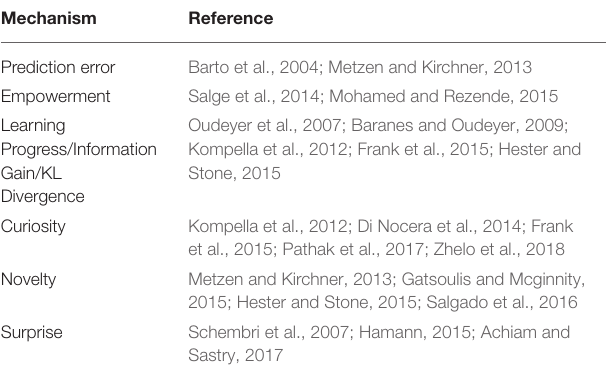
TABLE 3 | Reward mechanisms in computational models of